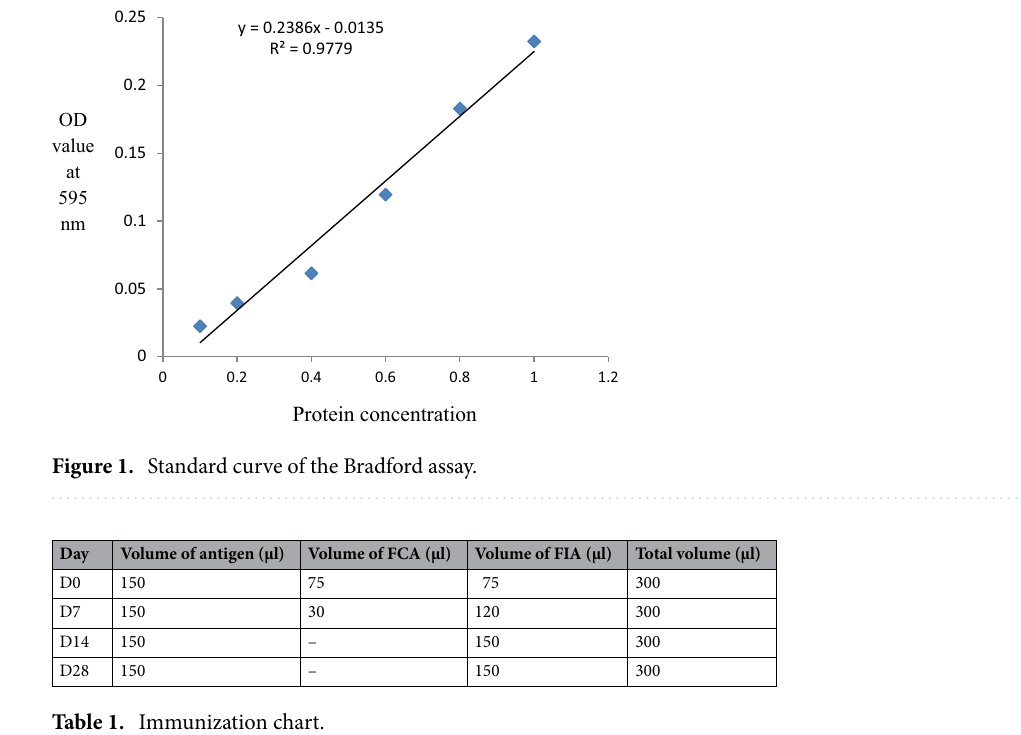
Table 1. Immunization